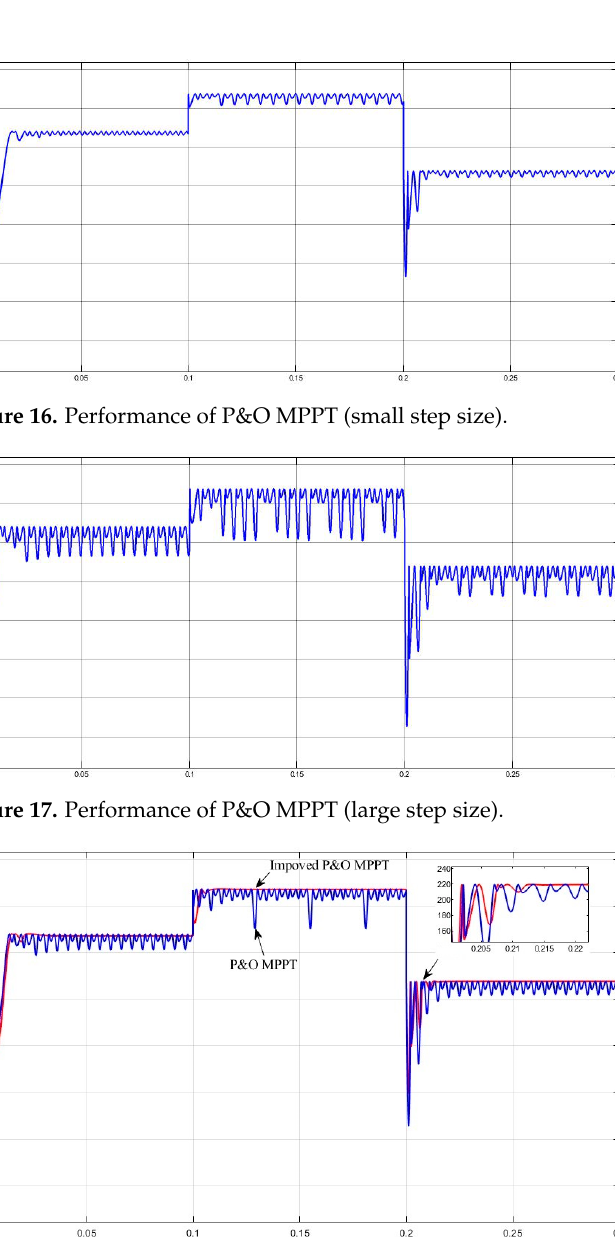
Figure 15. MATLAB/Simulink model of the solar PV module with P&O MPPT method.